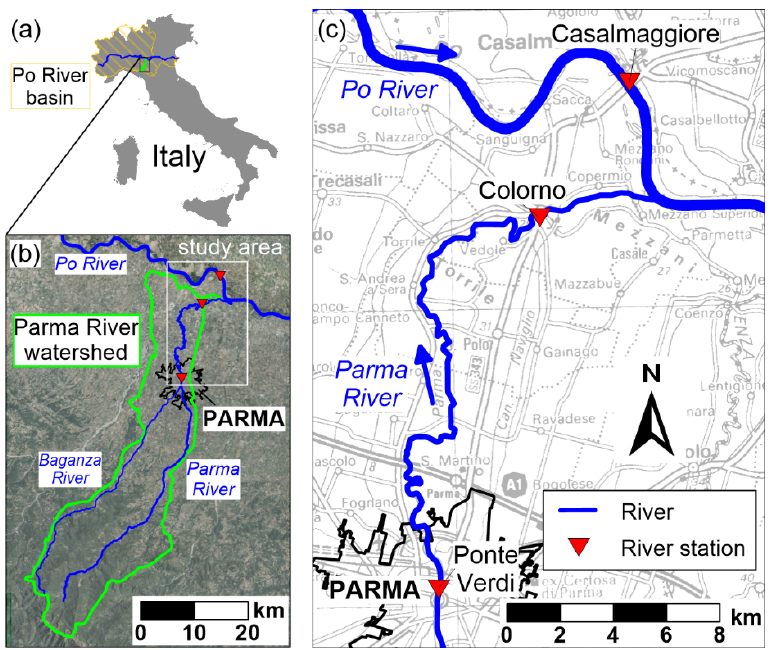
Figure 1. Overview of the study area: ( a ) locations of the Po and Parma basins in Italy; ( b ) location of the study area (white) in the Parma River watershed (green), with identification of the rivers (blue) and of the town of Parma (black); ( c ) sketch of the study area and of the river stations considered in this work.